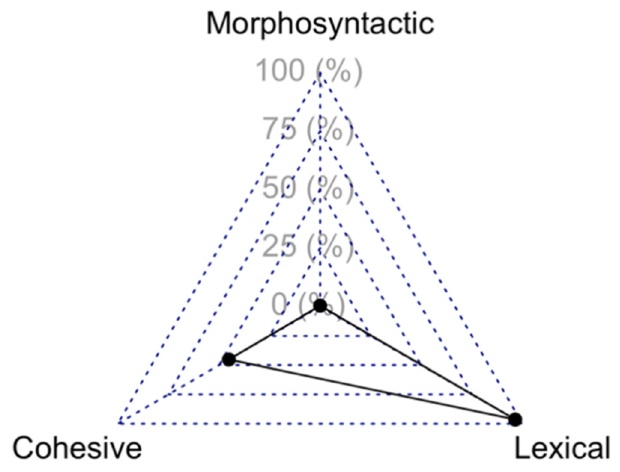
Figure 6. Radar Chart of the attribute mastery probabilities of student 8.